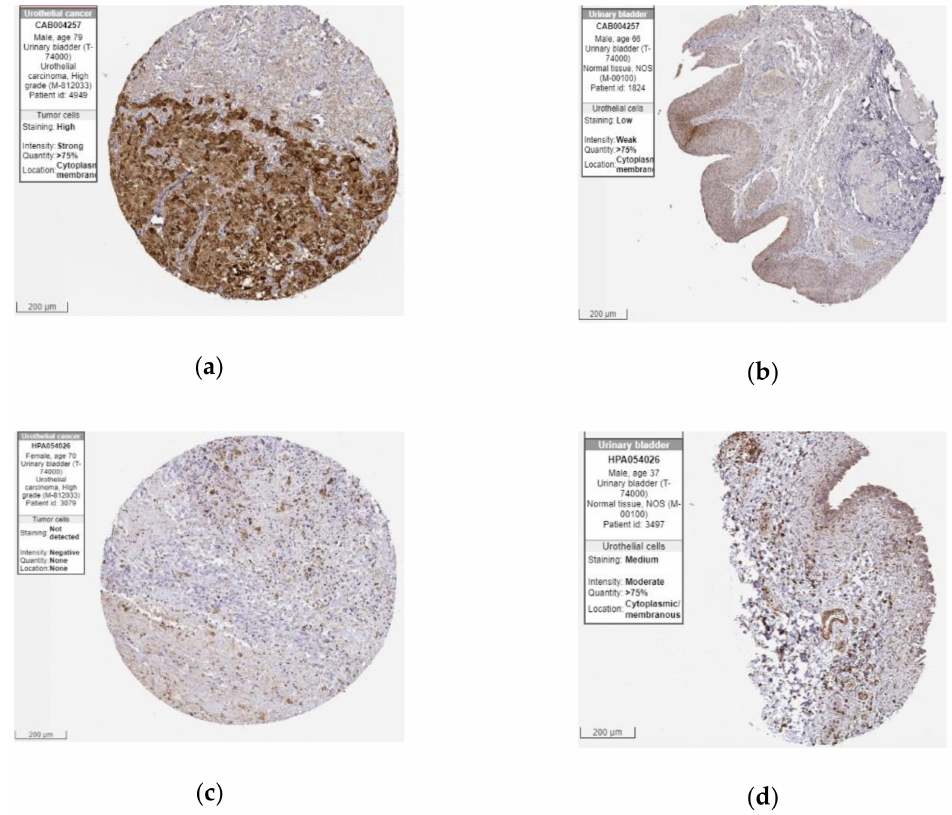
Figure 10. Immunohistochemistry of LAMC2 and GSN gene in bladder cancer (BLCA) and normal tissues from the Human Protein Atlas (HPA) database. ( a ) Protein levels of LAMC2 in BLCA tissues (antibody CAB004257; staining: high; intensity: strong; quantity: > 75%); ( b ) Protein levels of LAMC2 in normal urinary bladder tissues (antibody CAB004257; staining: low; intensity: weak; quantity: > 75%); ( c ) Protein levels of GSN in BLCA tissues (antibody HPA054026; staining: not detected; intensity: negative; quantity: none); ( d ) Protein levels of GSN in normal urinary bladder tissues (antibody HPA054026; staining: medium; intensity: moderate; quantity: >